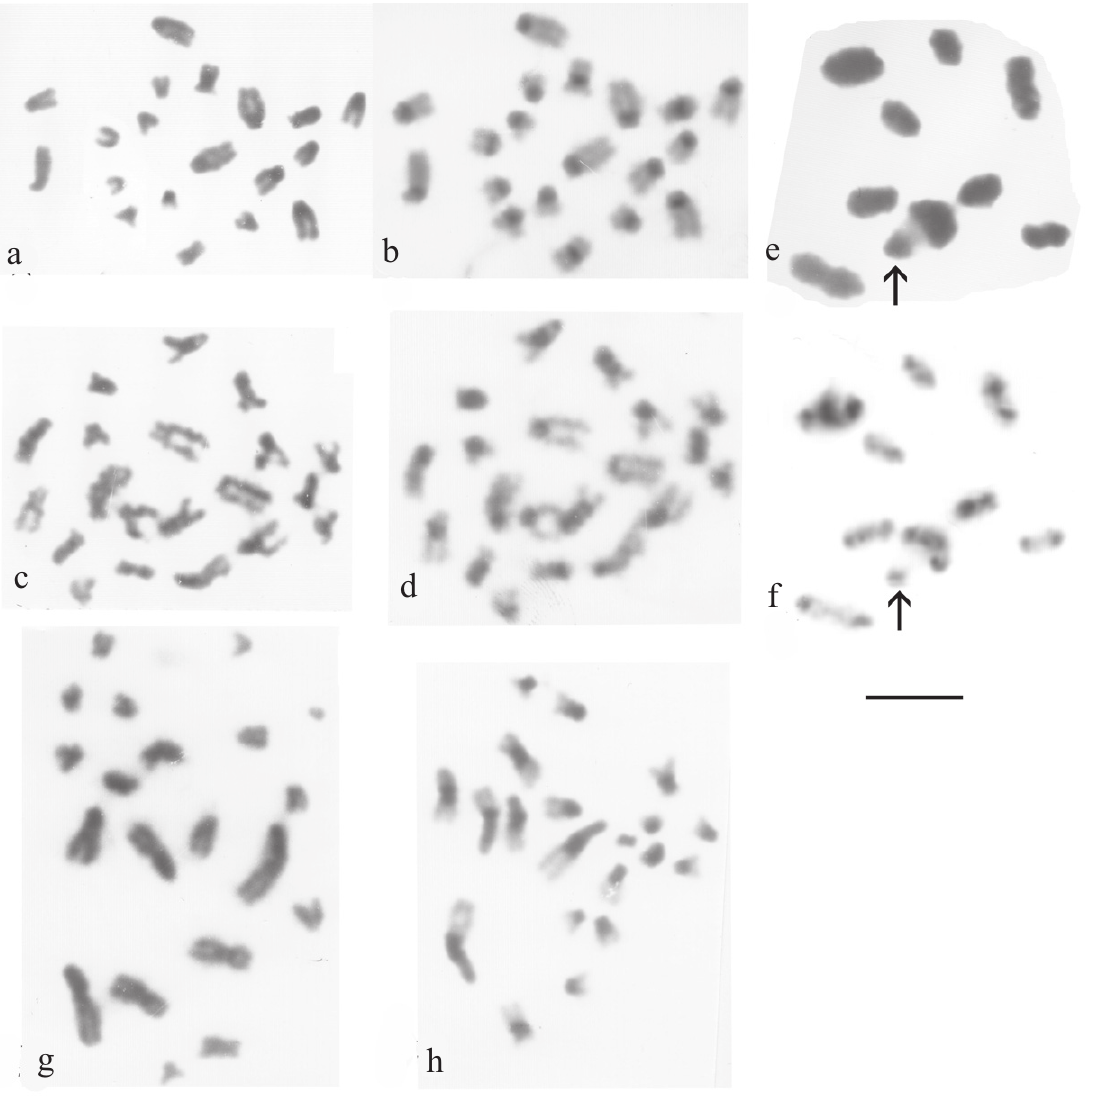
Fig. 1, a-h. Mitotic ( a-d, g, h, ) and meiotic ( e, f ) chromosomes of Aphodius spp. a - A. abdominalis , ♂, mid- gut cell, plain. b - the same nucleus, C-banded. c - A. abdominalis , ♀, mid-gut cell, plain. d -the same nucleus, C-banded. e - A. abdominalis , ♂, meiosis, metaphase I, plain. f - the same nucleus C-banded. The X chromosome is arrowed. g - A. bonvouloiri , ♂, mid-gut, plain. h - A. bonvouloiri , ♂, mid-gut, C-banded. Bar = 5